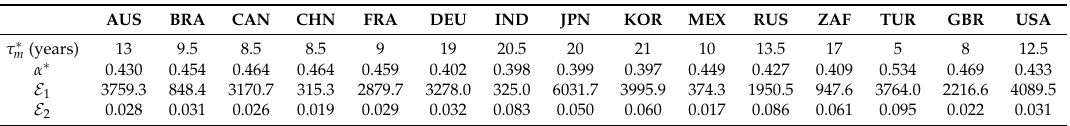
Table 2. The values of τ ∗ m , α ∗ , E 1 , and E 2 for the set of 15 countries: Real data for 1970–2013 and comparison between real and estimated values for